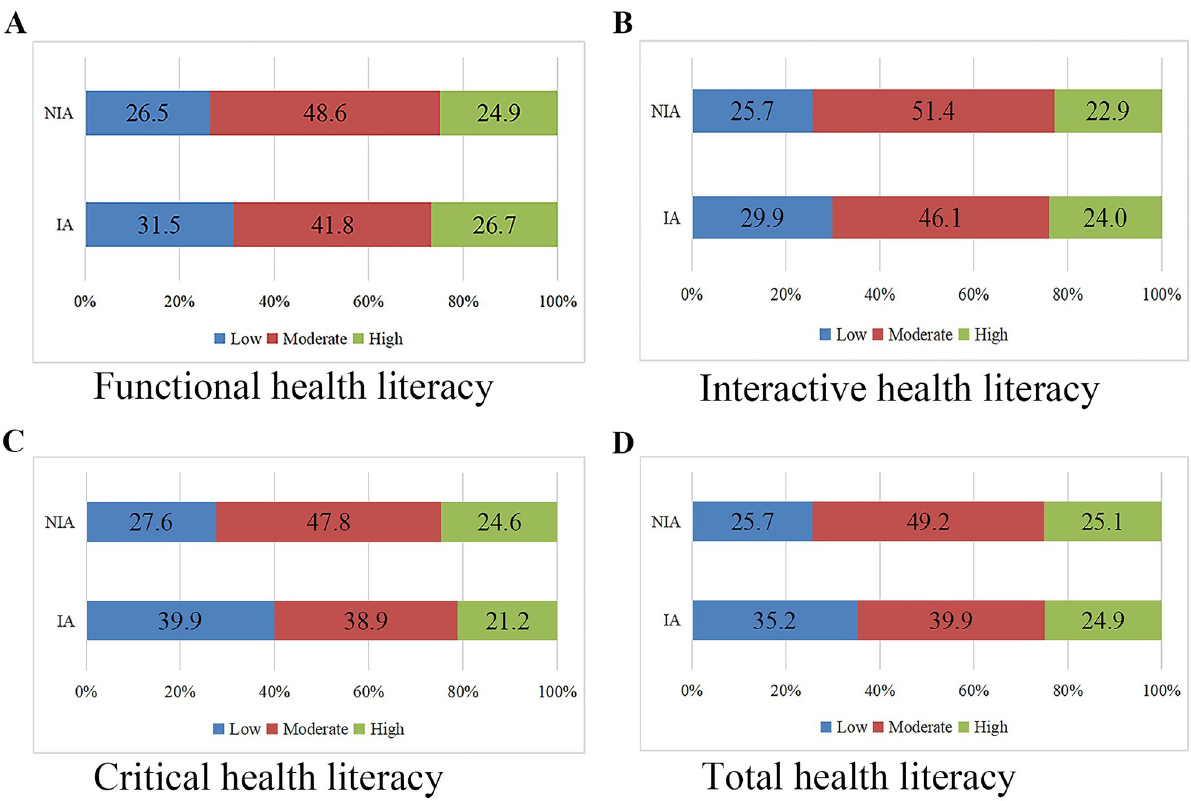
Fig 2. Proportions of high, moderate, and low health literacy between IA and NIA groups across different dimensions (%).